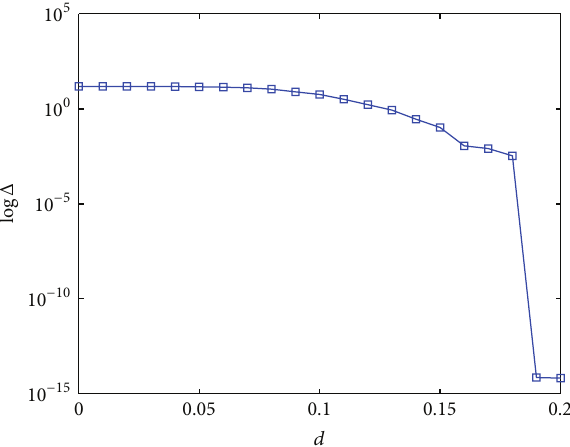
Figure 1: The evolution of Δ with respect to 𝑑 in three coupled Lorenz systems, when 𝑐 = 0 , 𝑇 0 = 4 × 10 3 , and 𝑇 1 = 5 × 10 3